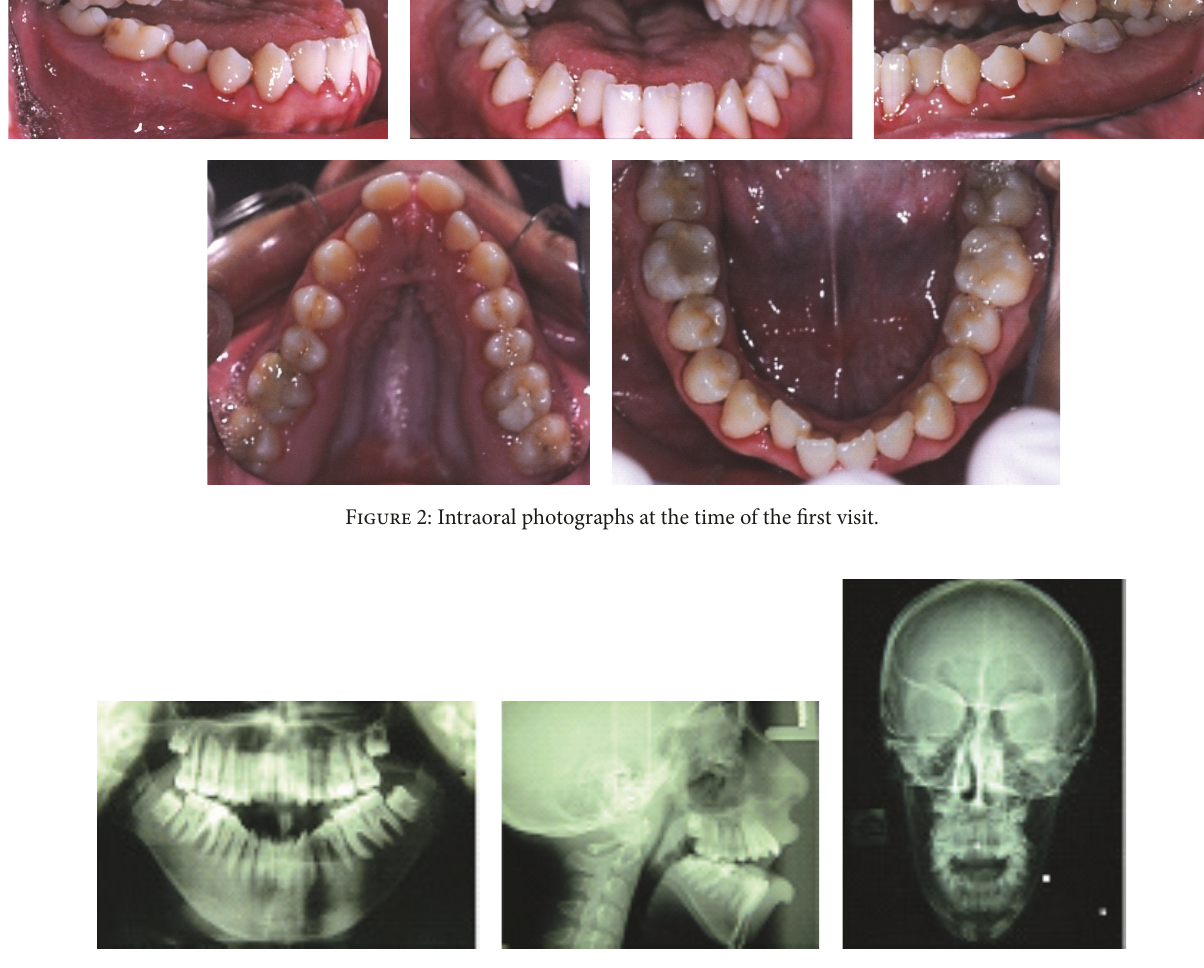
Figure 3: Rx before